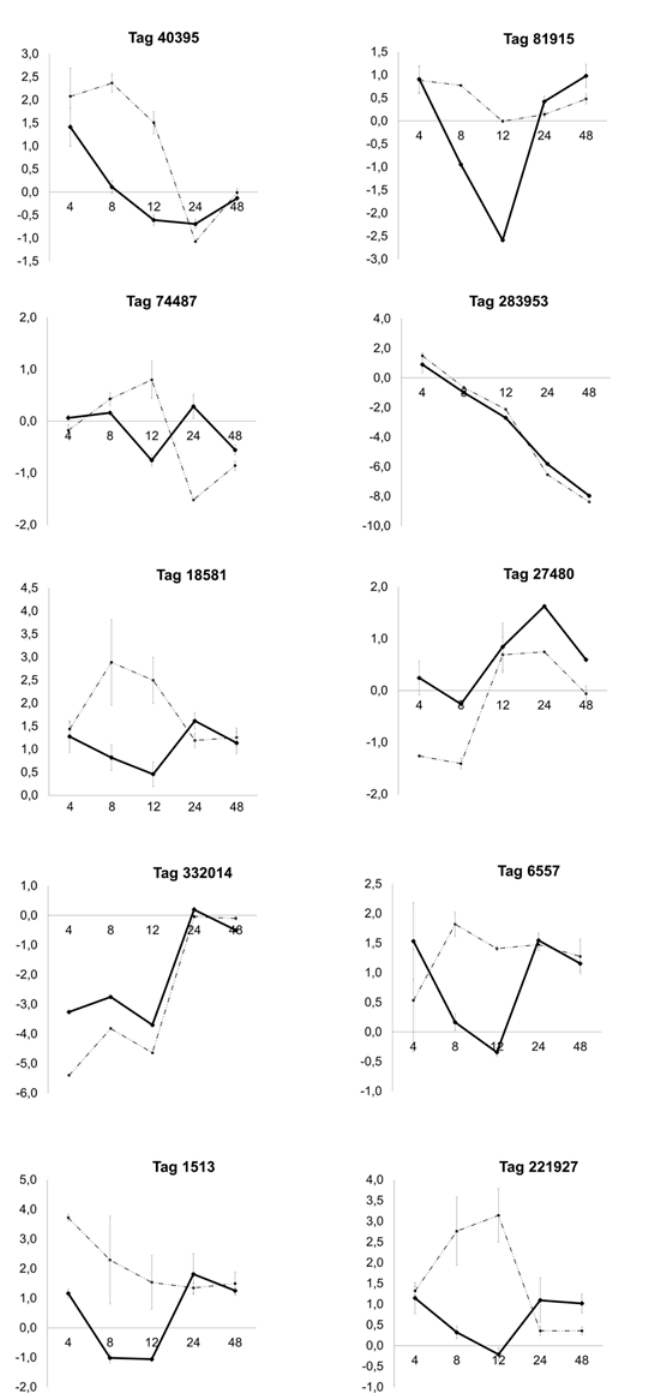
Figure 3. Analysis of mRNA accumulation corresponding to selected UniTags by qPCR. Examples of the kinetics of mR - NAs for 10 UniTags analyzed by qPCR 4, 8, 12, 24 and 48 hours after inoculation with A. fabae . Relative mRNA quantifica - tion was performed using ACT1, CYP2 and ELF1A, as a reference genes for normalization. The data values point was set arbitrary to 1. Transcripts levels were analyzed in three biological replicates (n =